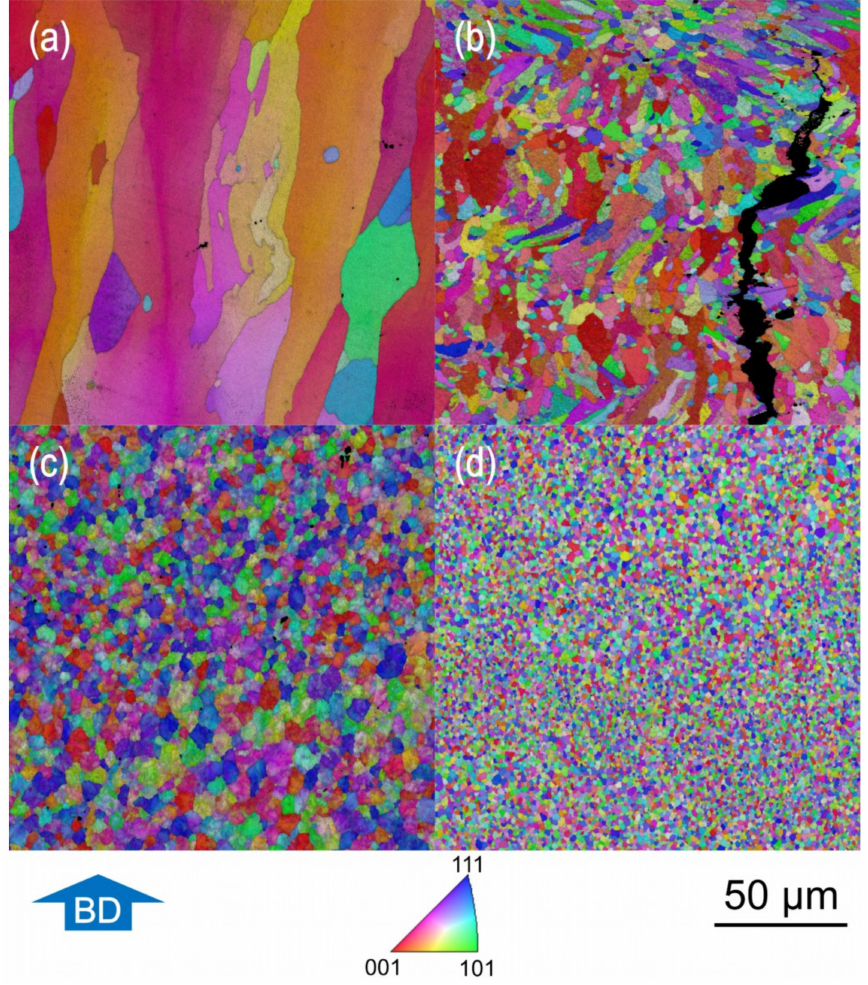
Figure 7. SEM-EBSD images indicating the grain structure of samples achieved with different powder variants: ( a ) AA7075, ( b ) AA7075/TiC/0.5, ( c ) AA7075/TiC/1.0, and ( d )